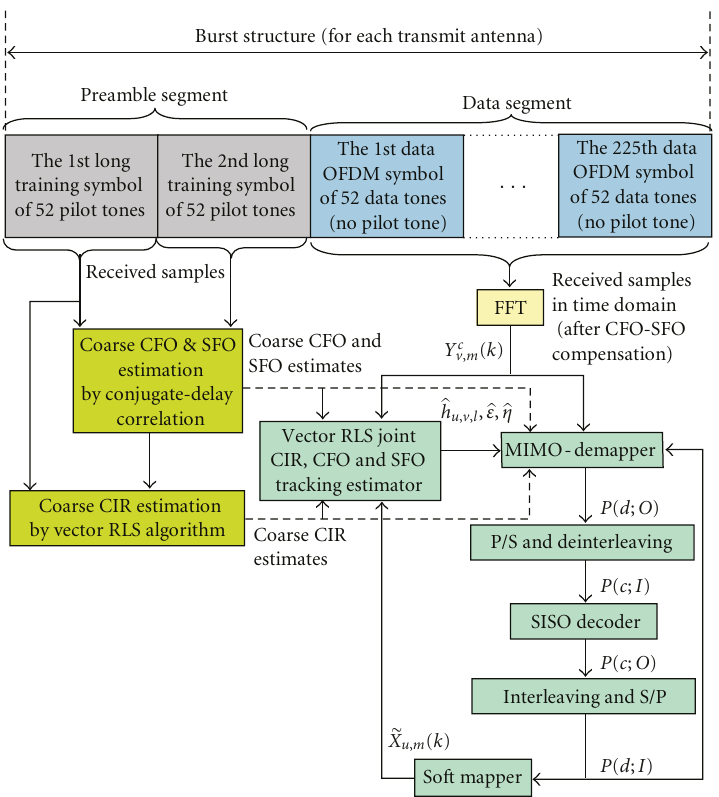
Figure 3: Turbo processing for joint channel estimation, synchronization, and